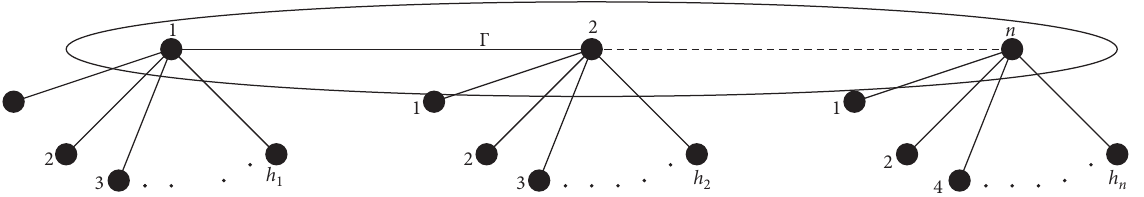
Figure 1: Thorn graph Γ h of the path graph Γ � P